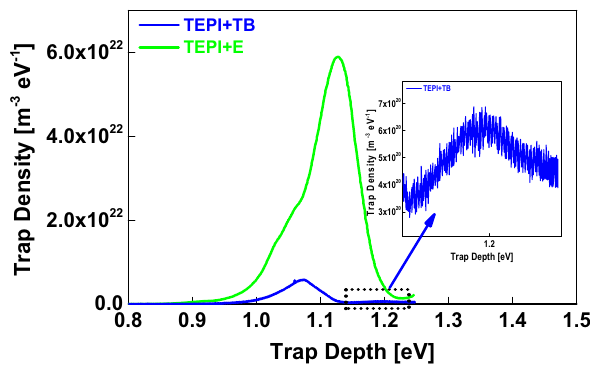
Figure 14: TSDC spectra of the nanocomposites fi lled with the TEPI + E and the TEPI + TB.